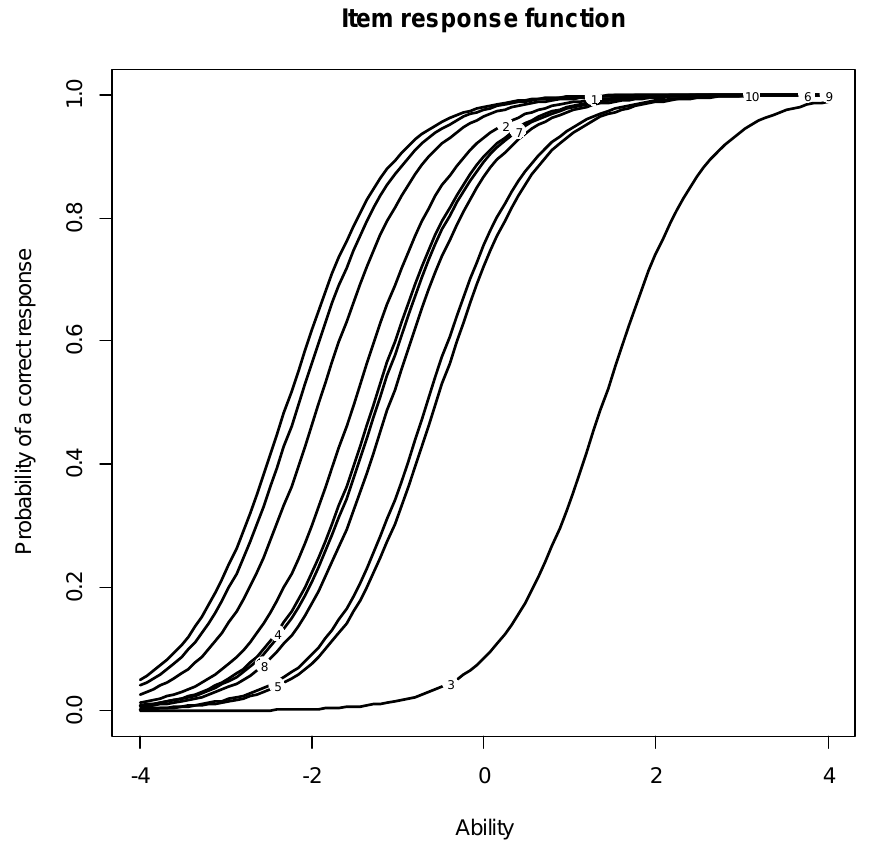
Figure 1. IRT Characteristic Curves for Survey Items.